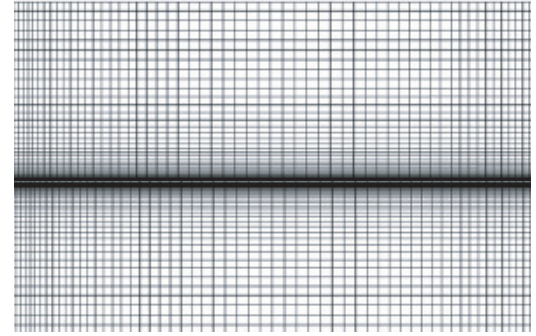
Figure 4. Mesh used in CFD